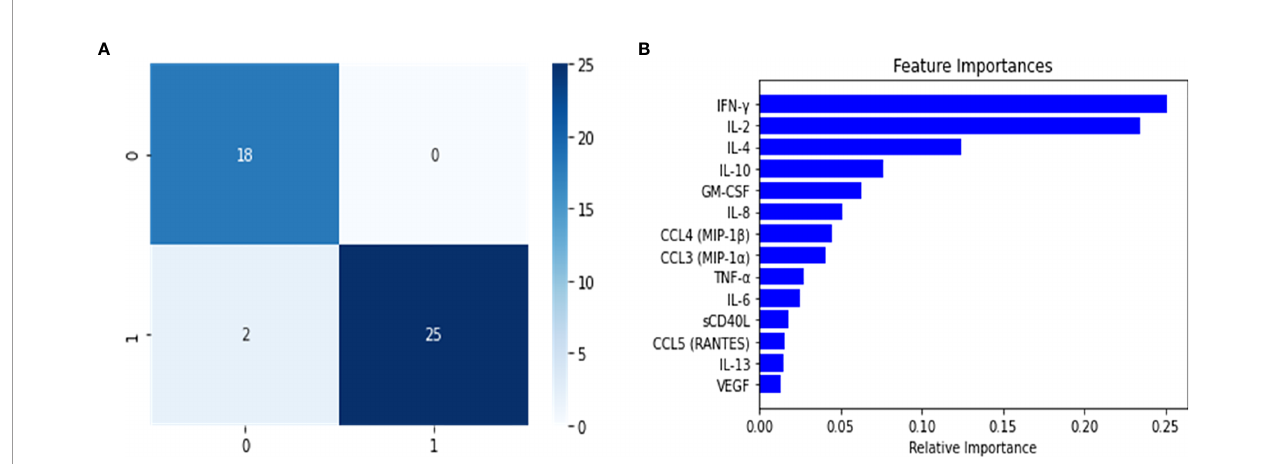
FIGURE 5 | Confusion matrix (A) and variable importance (B) for the Severe binary classi fi er constructed using the random forest classi fi er. The results shown in the confusion matrix were calculated for test split, where 0 represents the grouped Mild-Moderate and healthy control instances, and 1 are the Severe cases. For B, the most signi fi cant variables were to calculate a disease group score for Severe